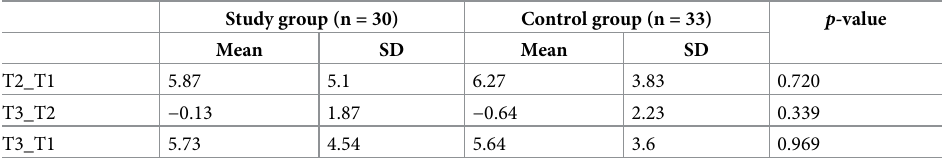
Table 5. Differences in total knowledge scores of the pregnant women at T1, T2, and T3.